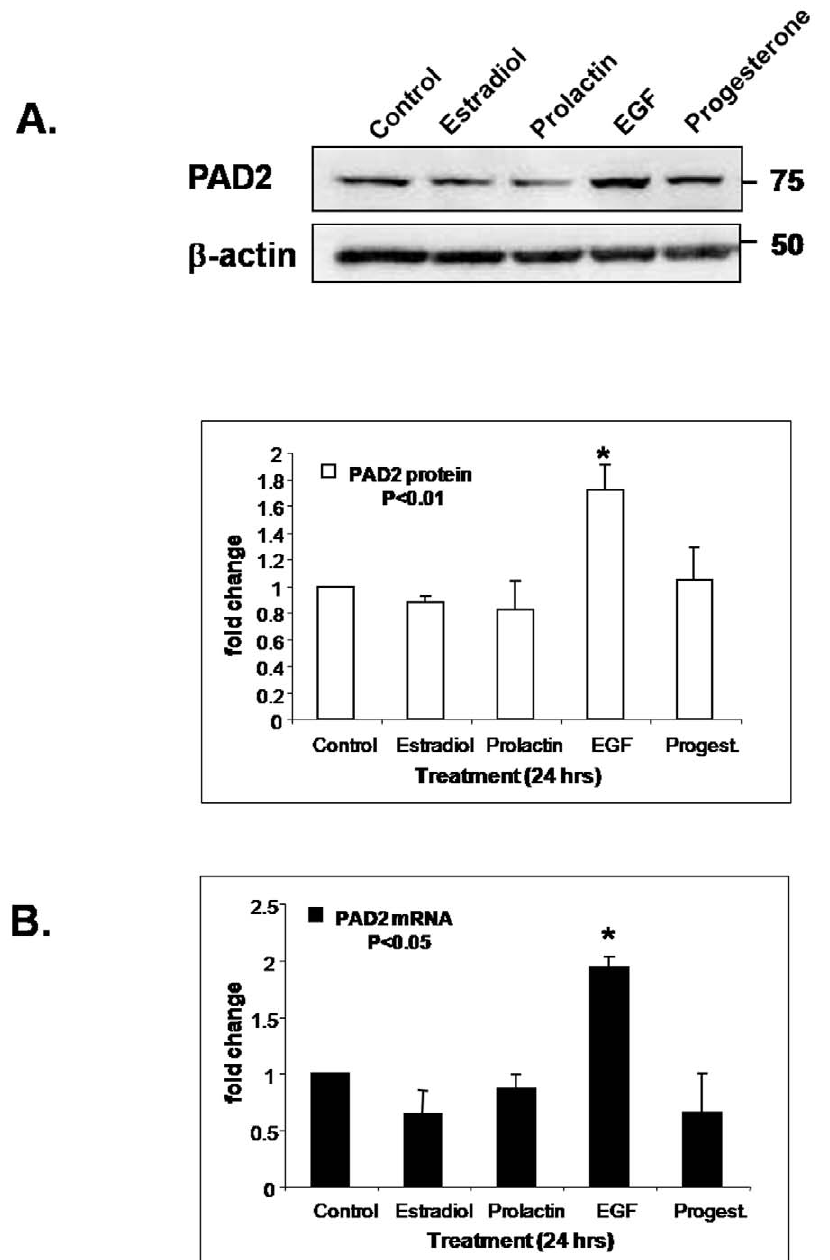
Figure 3. Treatment of the canine mammary tumor (CMT25) cell line with EGF results in an increase in PAD2 expression levels. (A) Western blot illustrating that only EGF treatment increases PAD2 protein levels with b -actin shown as a loading control. Densitometry measurements quantified treatment groups compared to vehicle treated control in three independent experiments and bars represent the means 6 SEM. * indicates a statistically significant difference from other treatments (P , 0.01) (B) Quantitative PCR analysis revealed elevated PAD2 transcript levels in CMT25 cells treated with EGF compared to vehicle treated control and * indicates a statistically difference from the other treatments (P , 0.05).